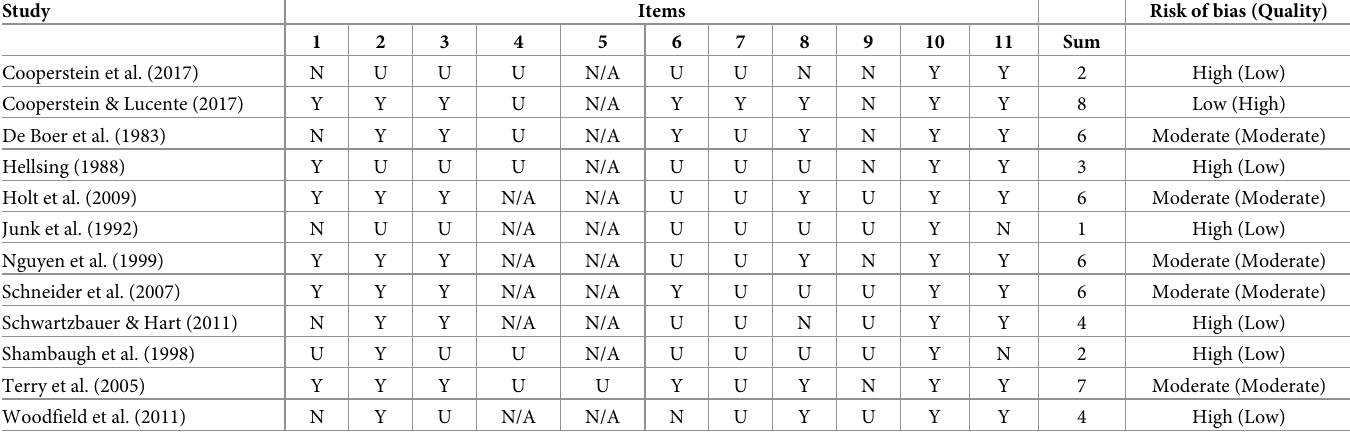
Table 3. QAREL-checklist for the evaluation of quality of the included reliability studies on clinical assessments for the measurement of leg length discrepancy (n = 12).